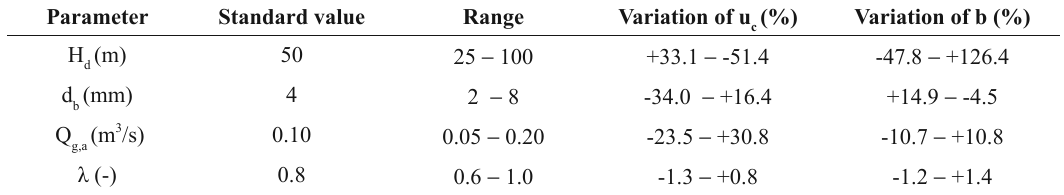
Sensitivity analysis of the present model: aeration mode.